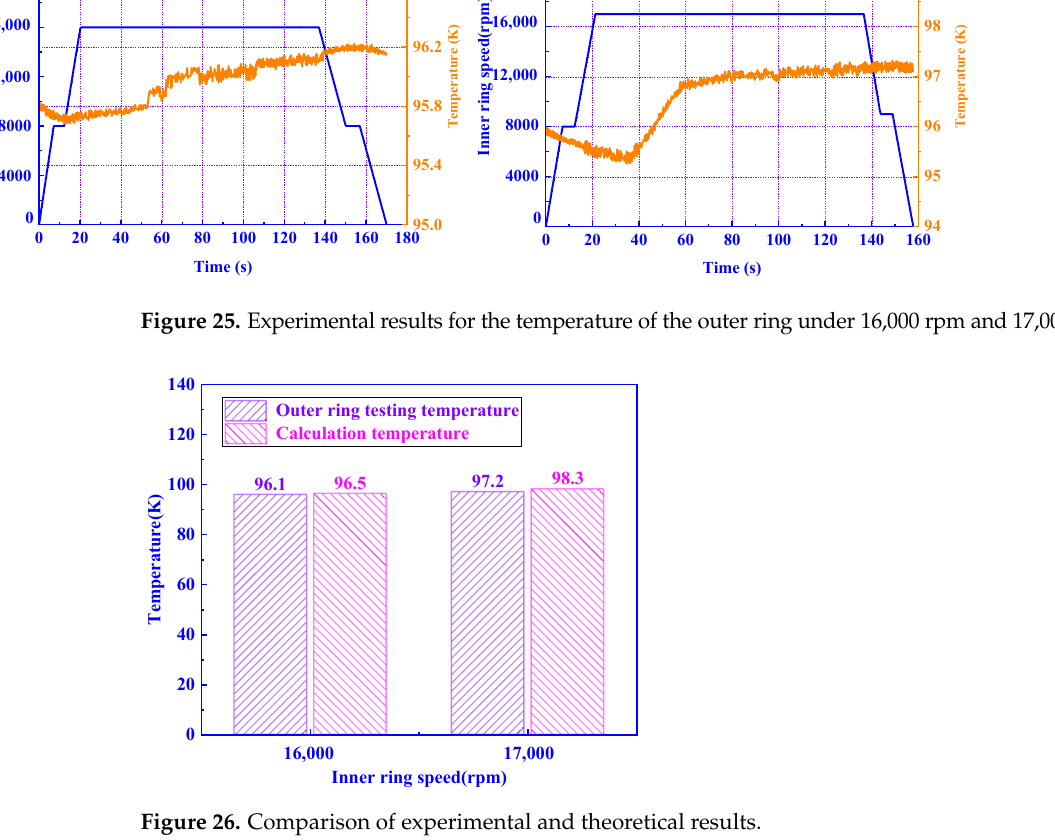
Figure 26. Comparison of experimental and theoretical results.